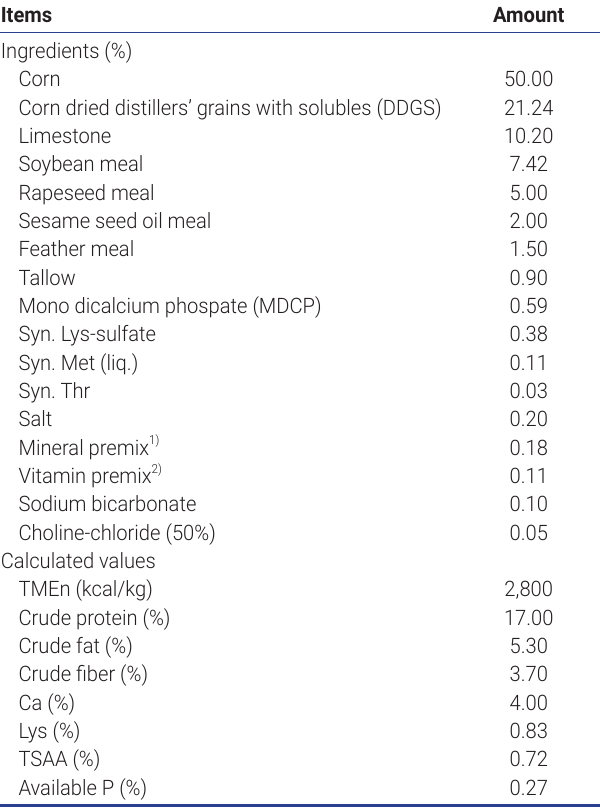
Table 2. Ingredients and chemical compositions of the basal